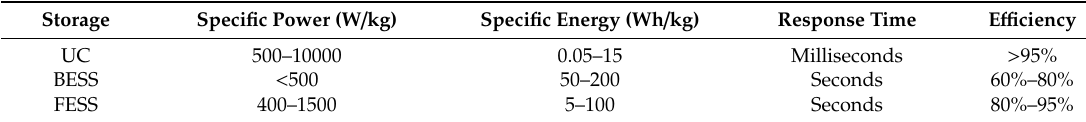
Table 2. Energy storage comparison [12].